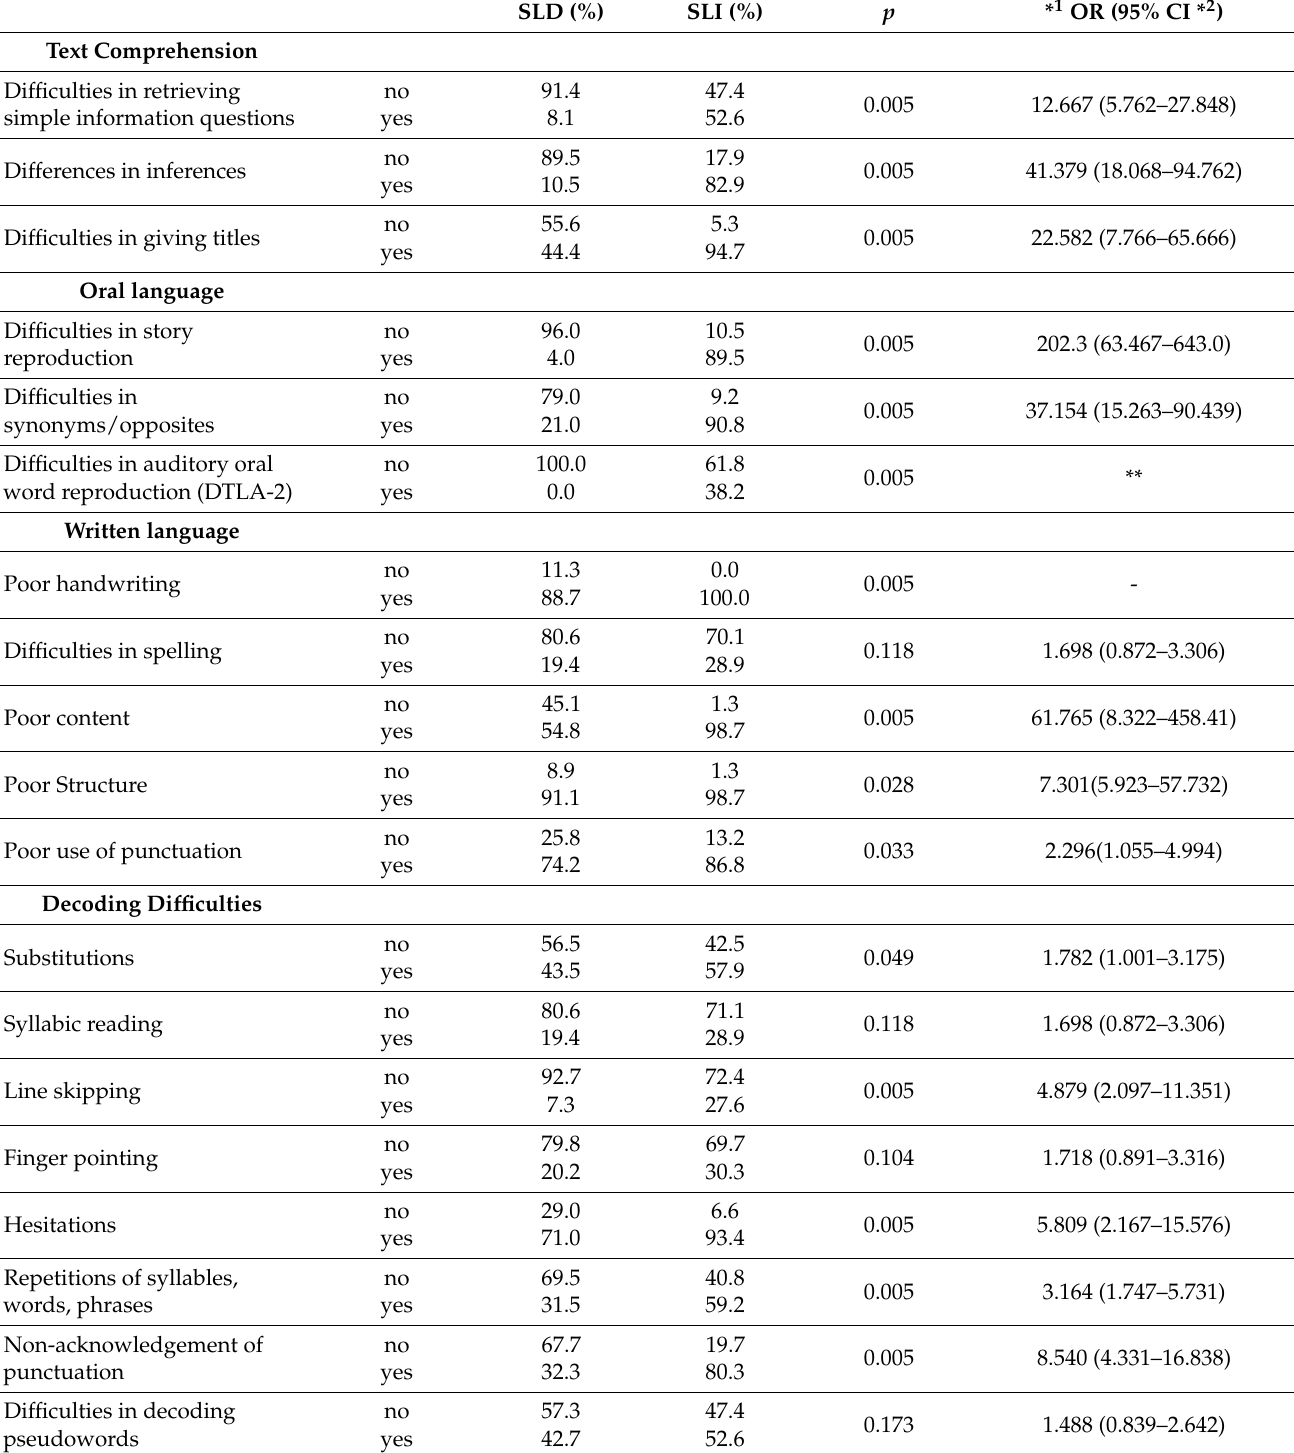
Table 3. Results of chi-square test and odds ratio for text comprehension, oral and written language, decoding difficulties with respect to